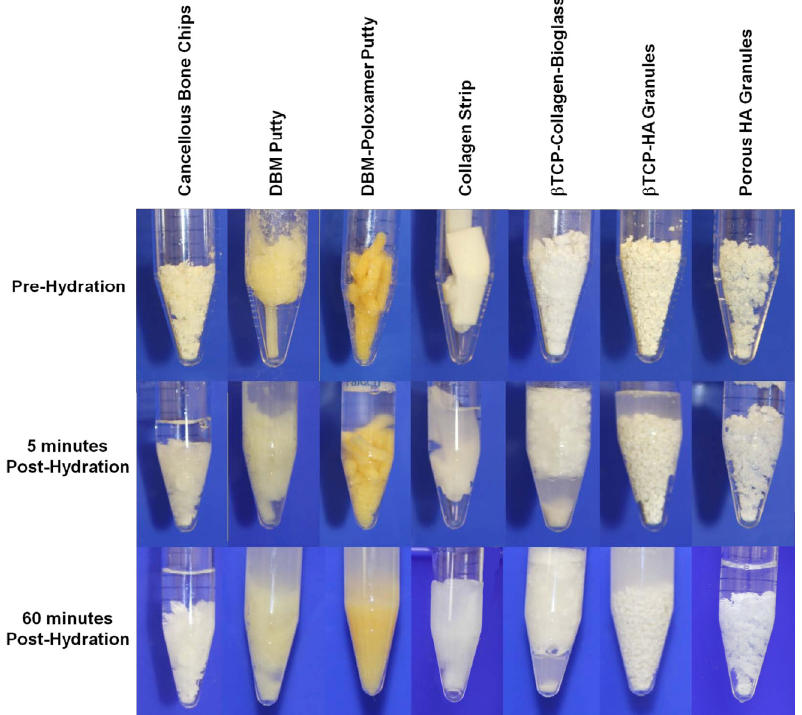
Figure 2. Cancellous bone chips, demineralized bone matrix (DBM) putty, DBM-poloxamer putty, collagen, β TCP-collagen-bioactive glass, β TCP-HA granules, and porous HA granules (left to right) prior to hydration with phosphate buffered saline (top row), 5 min after hydration (middle row), and 60 min after hydration (bottom